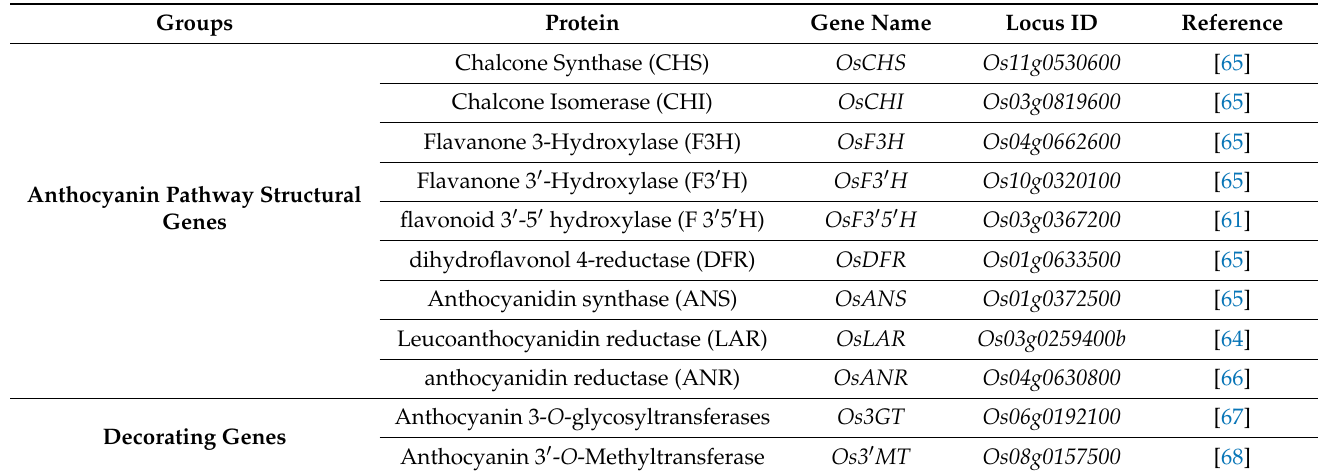
3. Trafficking and Accumulation of Anthocyanin in the Rice Caryopsis Anthocyanin accumulation in black rice is characterized by a gradual change in the color of the rice grain at different developmental stages (Figure 3A). The pigment gradient increases as the rice grain develop and gradually fills. The color of the caryopsis starts to be visible 8–14 days after flowering (DAF), and the caryopsis becomes black rapidly, mostly at the milk stage. The concentration of pigment is at a peak when rice is fully matured [38], 35–45 DAF (Figure 3B). This stage is the most appropriate period for harvesting because bioactive compounds are qualitatively and quantitatively well-balanced and thus more beneficial for health [31]. Likewise, the pigmentation increases with gene expression, and most of the genes are upregulated during the first 20 DAF with high activity between 7–18 DAF, while their peak is attained between 14–21 DAF [69].